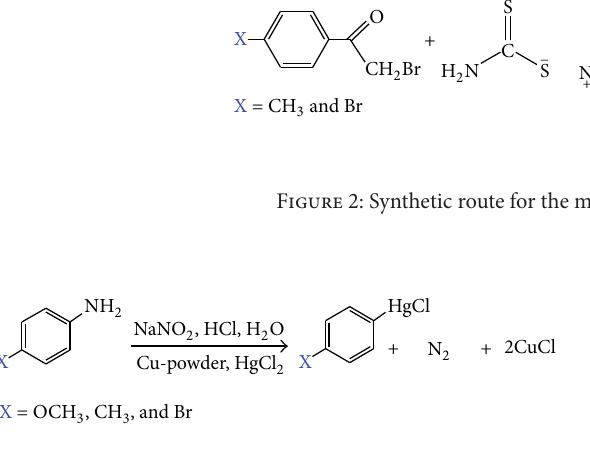
F 3: Synthetic route for the mercury (II) chloride derivatives